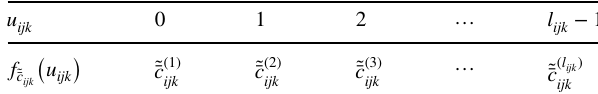
Table 3 Data for multi-choice parameter ̃ d ijk